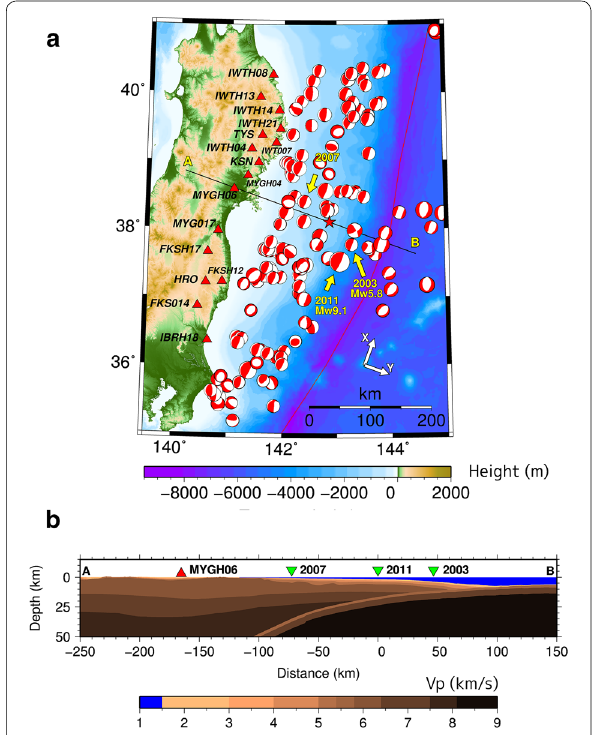
Fig. 1 a The study area: northeastern Japan and Japan Trench. The GCMT solutions in the oceanic area from 01/01/1996 to 30/09/2017 ( M W ≥ 5.8 and depth ≤ 50 km ) are drawn. The GCMT solutions of the 01/11/2003 event (EV2003) and of the 25/12/2007 event (EV2007) are indicated by yellow arrows. The station locations are denoted by red triangles. The directions of the horizontal axes ( X and Y ) of the finite-difference grid are indicated by white arrows: the X axis is N20 ◦ E , and the Y axis is N110 ◦ E. b Example of a vertical cross section of the land–ocean unified 3D structure model: the cross section along the line A – B shown in a is displayed. Blue color denotes the ocean water layer. The epicenters of EV2003, EV2007, and the 2011 Tohoku–Oki earthquake ( M JMA 9.0) determined by JMA are projected (green